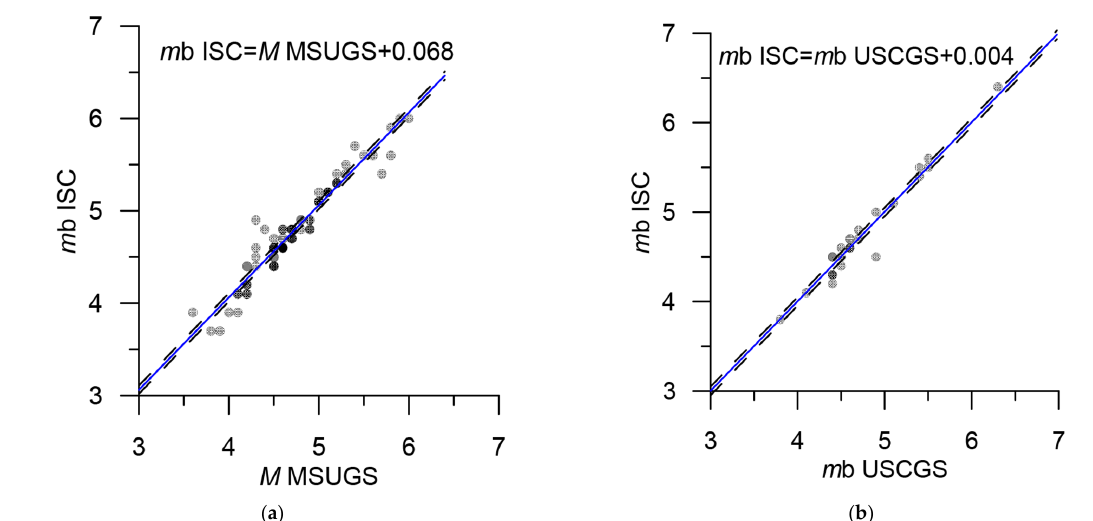
Figure 17. Correlation ratios “shift” of ( a ) the ML AEIC and mb ISC magnitudes; indirect relationships; ( b ) ML AEIC and ML NEIC ; and ( c ) ML AEIC and mbLG NEIC . The dashed lines show 95% confidence intervals.